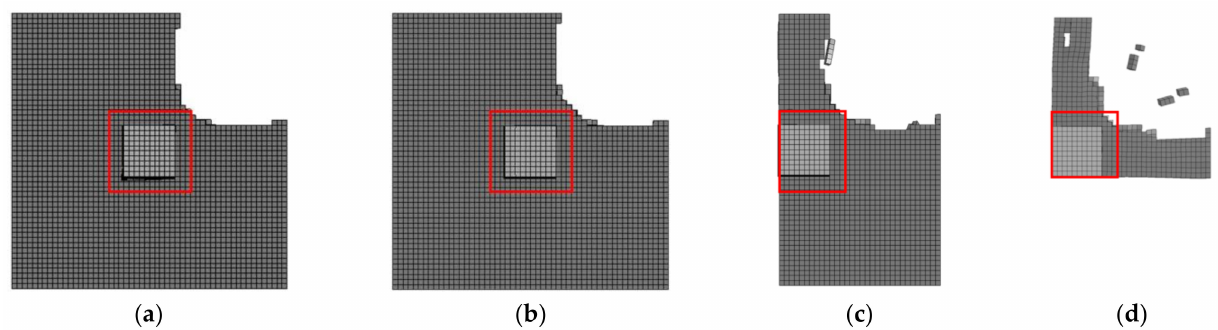
Figure 8. Critical section and slab failure shapes of specimens with TNT 12 kg: ( a ) IC12; ( b ) IC-D12; ( c ) EC12; ( d ) CC12. Table 4. Maximum deflection and support rotation at critical section.